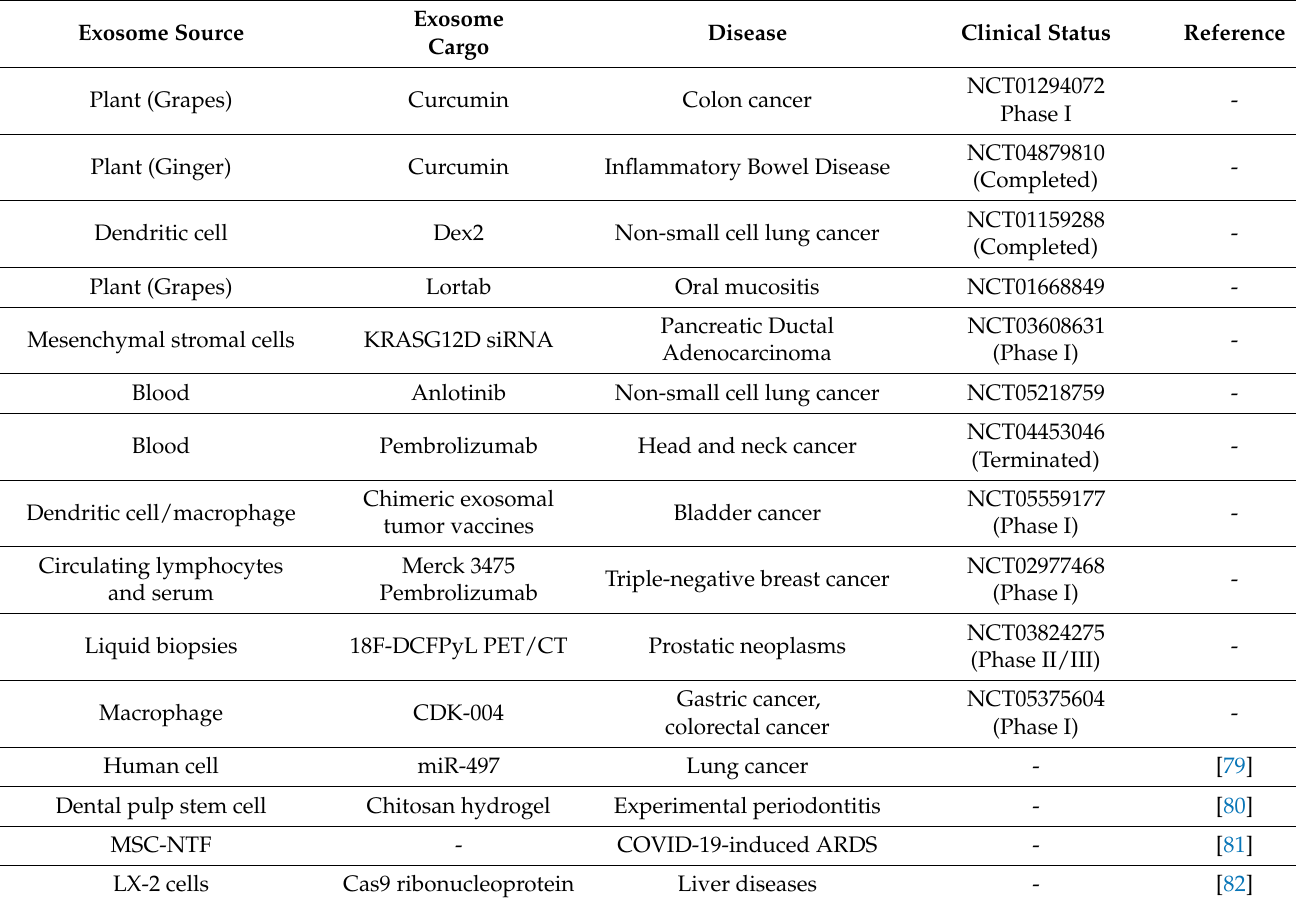
Table 2. Summary of exosomal cargo in pre-clinical and clinical trials as